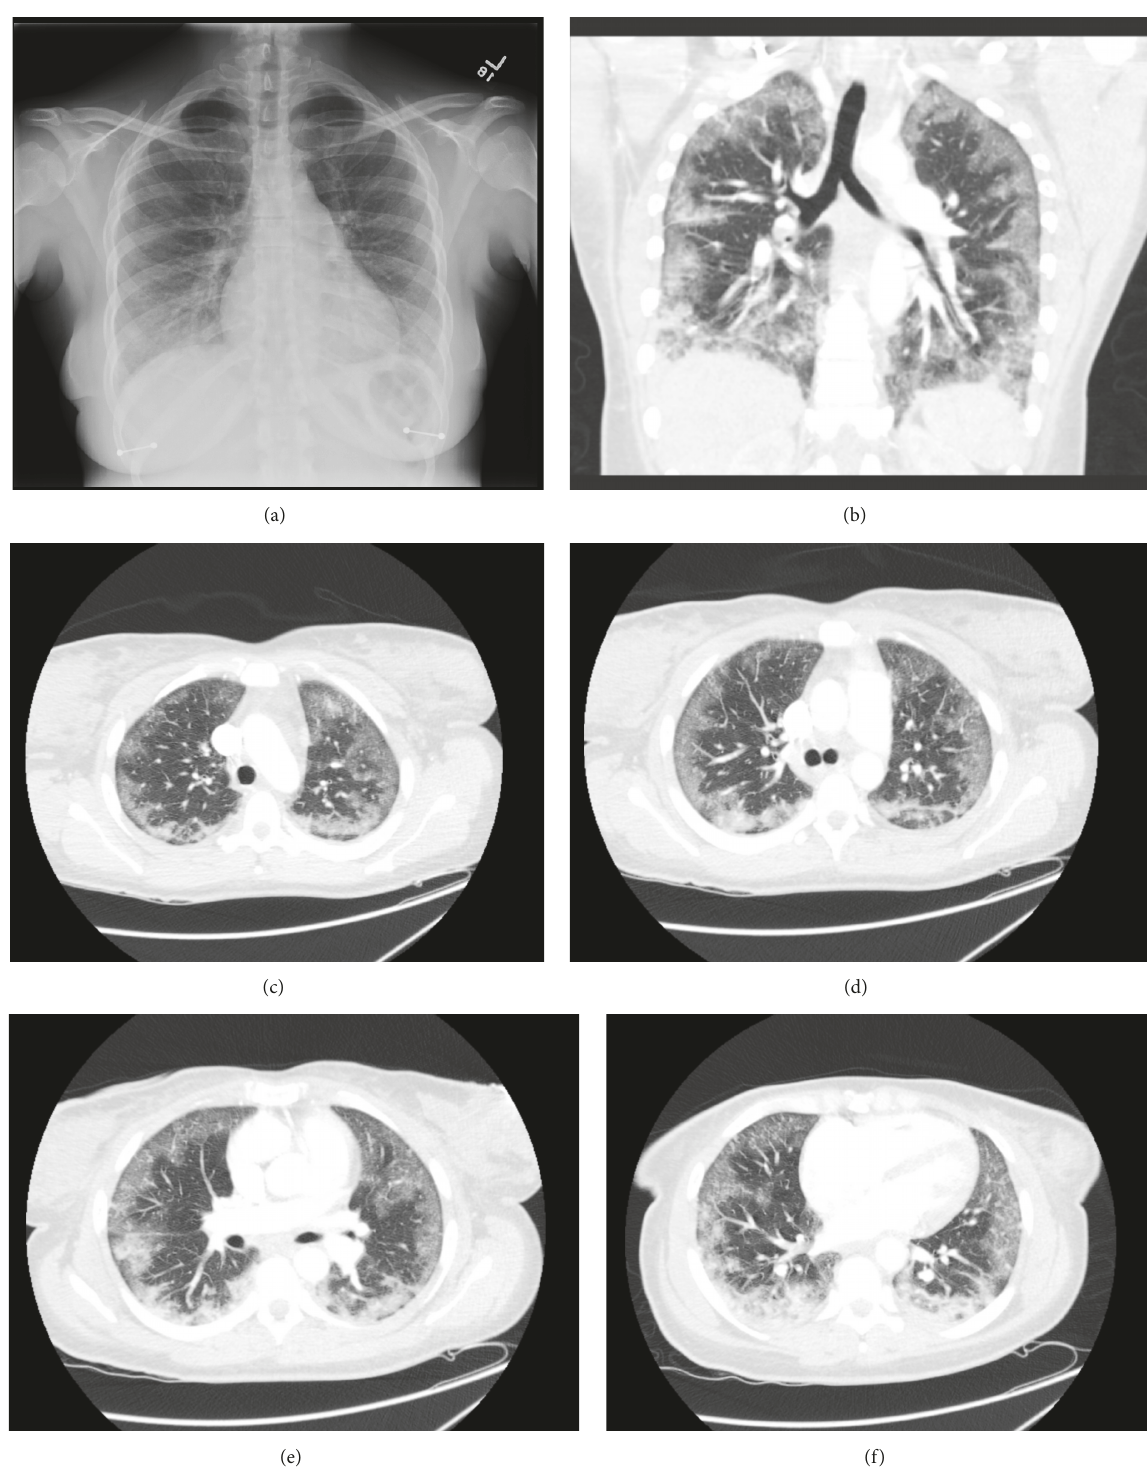
Figure 1: (a) Chest X-ray PA view shows increase attenuated over peripheral lung field without significant consolidation or nodularity. (b–f) Computed tomography of chest shows extensive, symmetric alveolar opacities with interspersed foci of interlobular septal thickening, subpleural sparing, and scattered ground-glass nodularity over the bilaterally periphery lung field, with perihilar sparing. No mediastinal, hilar lymphadenopathy or pleural